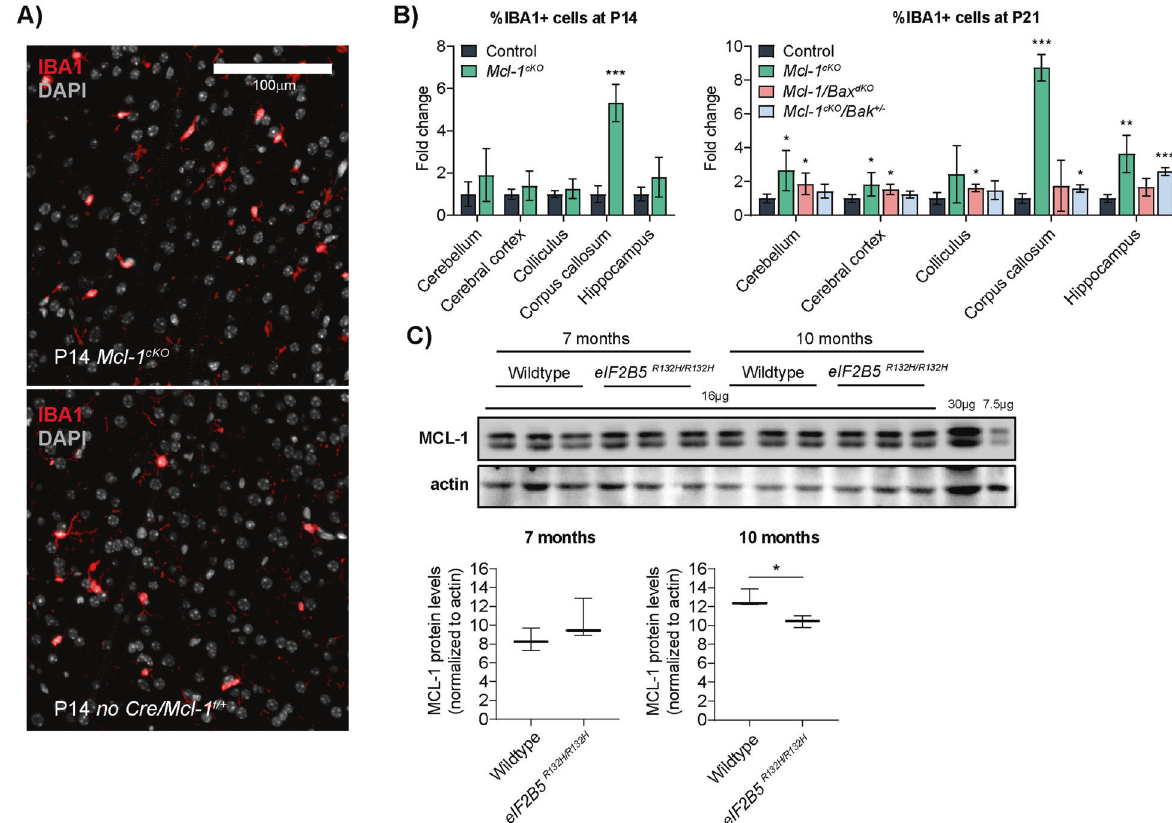
Fig. 7 Progressive neuroin fl ammation in Mcl-1 cKO mice and reduced MCL-1 protein in mice with VWMD. A , B IBA1 IHC, with representative images and quanti fi cation in the indicated genotypes, showing a progressive increase in microglia in Mcl-1 cKO mice, beginning in the corpus callosum at P14 and expanding to include diverse regions by P21. Co-deletion of Bak or Bax variably rescue microgliosis with different effects in different regions. *, **, and *** denote p < 0.05, p < 0.01, and p < 0.001, respectively, relative to controls. C Western blot comparing MCL-1 protein abundance in brain lysates of 7- and 10-month-old WT and eIF2B5 R132H/R132H mice, demonstrating reduced MCL-1 in 10-month-old mutant mice. * denotes p < 0.03, relative to